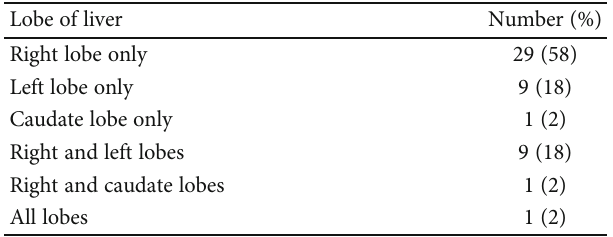
Table 4: Involvement of di ff erent lobes of the liver ( n = 50